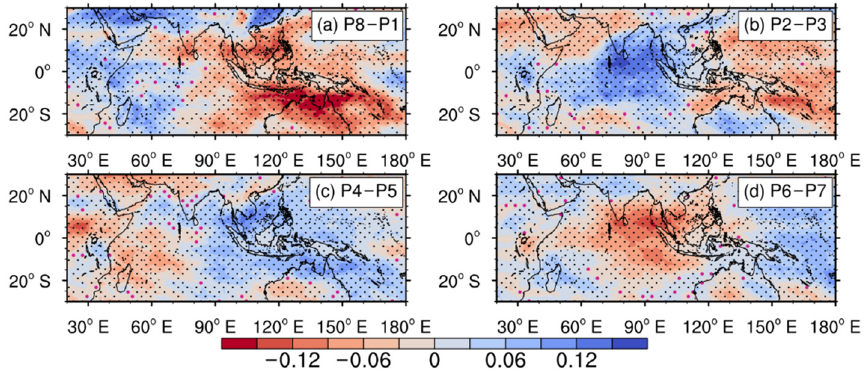
Figure 7. As in Figure 6 but for the anomalies of total cloud cover in ( a ) P8–P1, ( b ) P2–P3, ( c ) P4–P5 and ( d ) P6–P7. The purple and black dots indicate the 90% and 95% confidence according to the Student’s t-test.